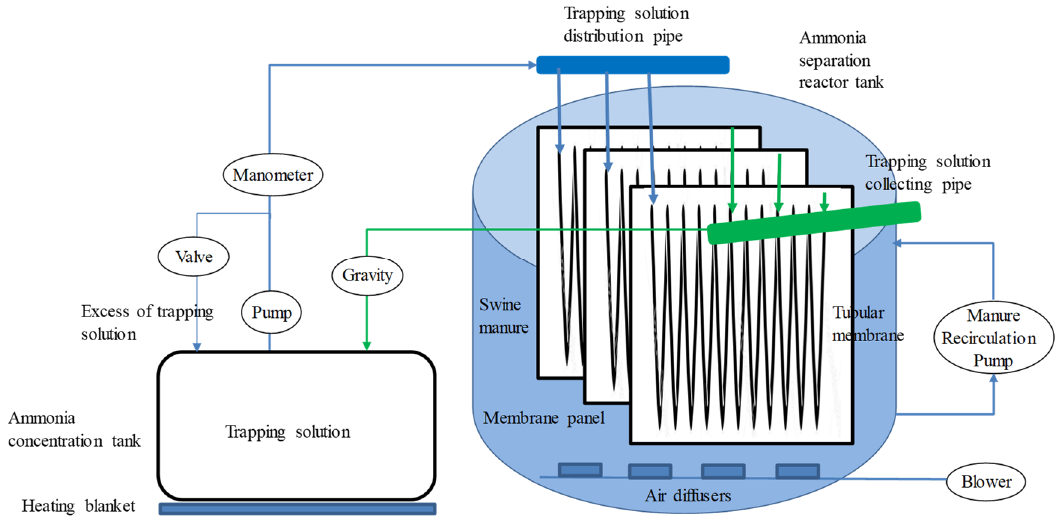
Figure 3. Schematic diagram of the pilot plant.